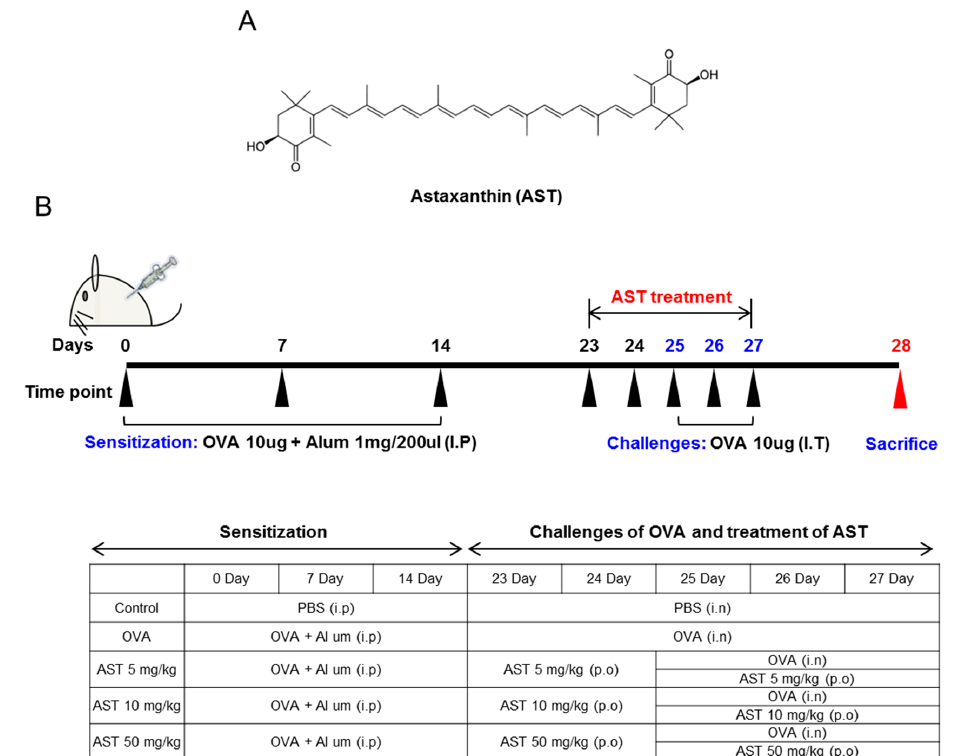
Figure 1. ( A ) The molecular structure of astaxanthin (AST); ( B ) Experimental protocol for the induction and therapy of airway inflammation along with the treatment scheme.